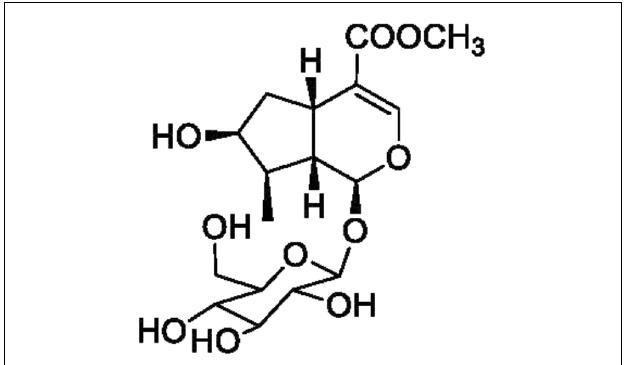
FIGURE 1 | Chemical structure of